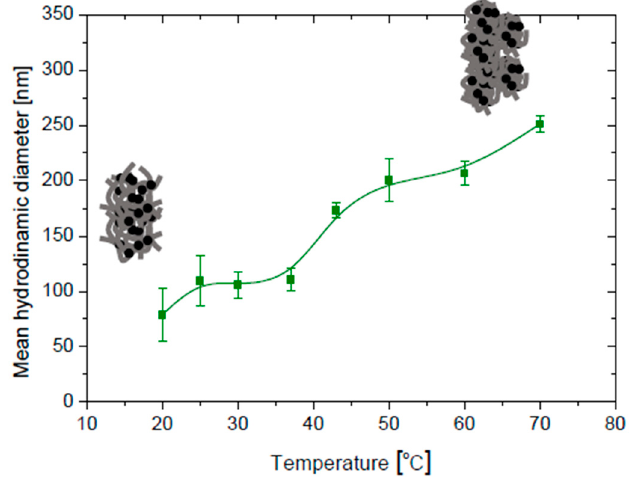
Figure 9. Effect of temperature on the hydrodynamic diameter of PDMAEMA-coated Fe 3 O 4 aqueous suspension at pH 7.